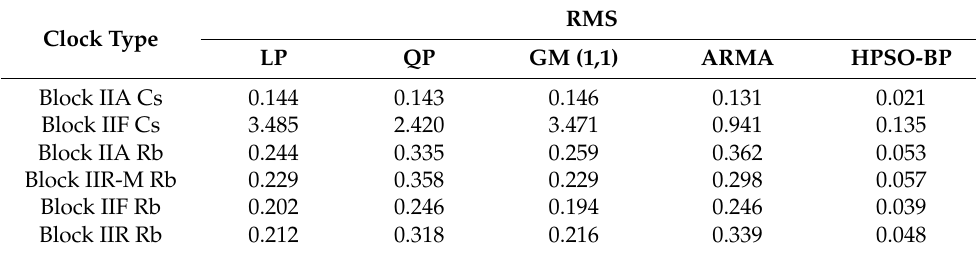
Table 9. Statistics of average prediction results of five models for six different clock types